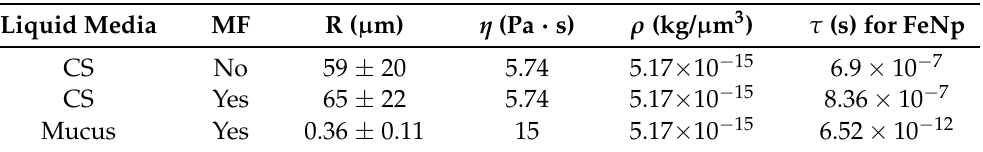
Figure 6. MNP velocity vs. time simulation. At time t = 0, all MNPs are released from a position 2500 µ m above a magnetic tip in corn syrup. MNP velocities reach v ter exponentially, within 5 × 10 − 17 s. Velocities in gravity and MF were calculated by solving for v ( t ) in Equations (1) and (3), respectively. Note that the displayed velocity for poly(lactic-co-glycolic) acid-dexamethasone FITC BaFe 12 O 19 nanoparticle (PLGA-Dex-FITC-BaNp) in MF is only valid at a position 2500 µ m above the magnetic tip, and will increase if the BaNp is positioned closer to the magnetic tip. Table 3. Characteristic time, τ of FeNps in corn syrup (CS) and mucus. All τ s are 10 − 7 s or less and hence have little effect on v ter . Characteristic time τ was calculated by Equations (7), (9), (10), and (18). Uncertainty in R was propagated from errors in r m and r n listed in Table 1, by the method of Section 2.8. The propagated uncertainties in τ were negligible.